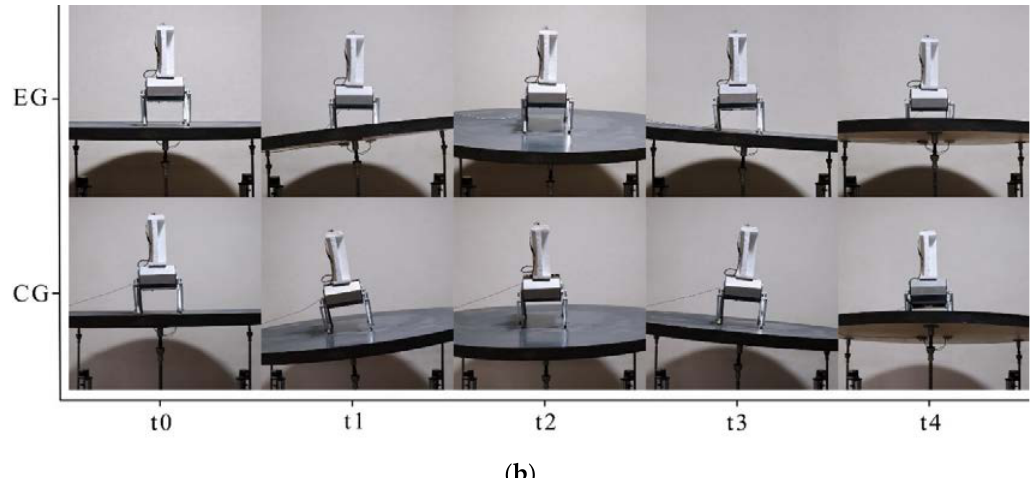
Figure 13. Snap-shots in real-world experiments: ( a ) Lateral view; ( b ) Front view.